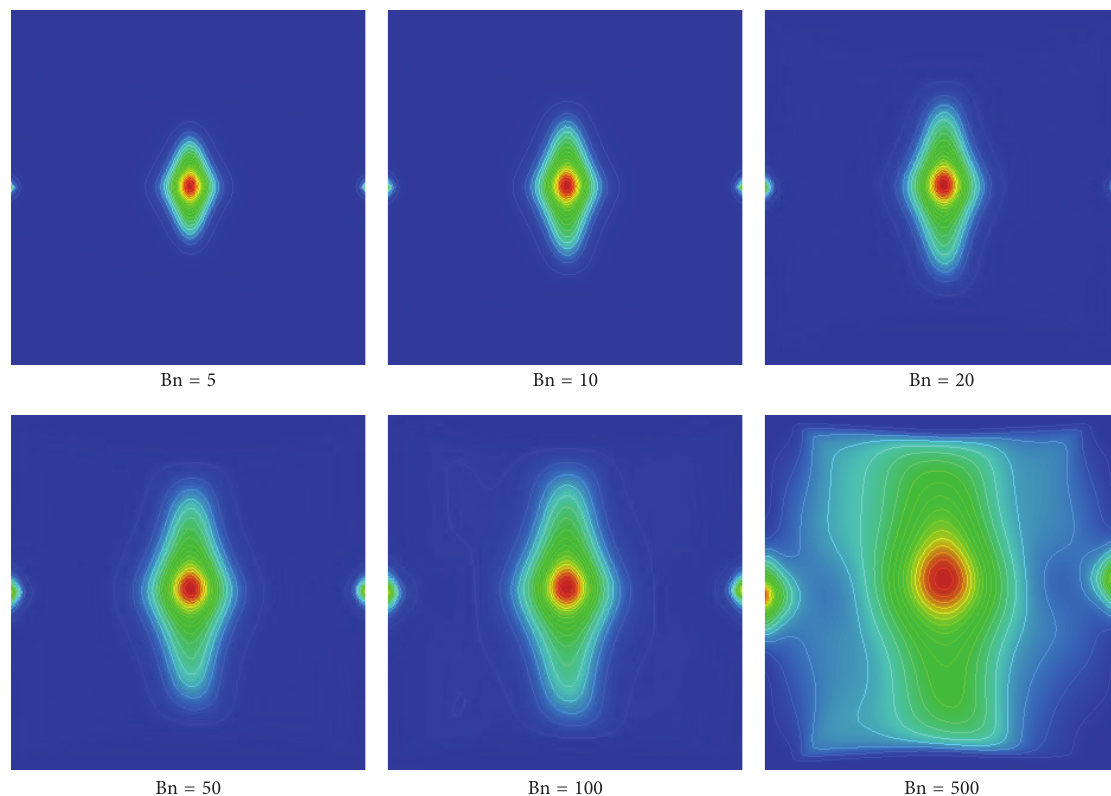
Figure 9: Viscosity contours for double lid driven cavity at different values of Bingham number Bn.